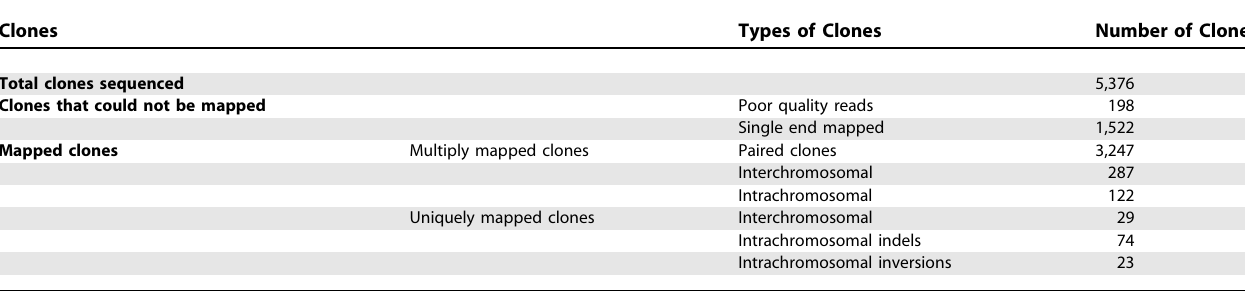
Table 2. Analysis Using the Pairing Criteria of Gibbon BES Mapped on the Human Genome